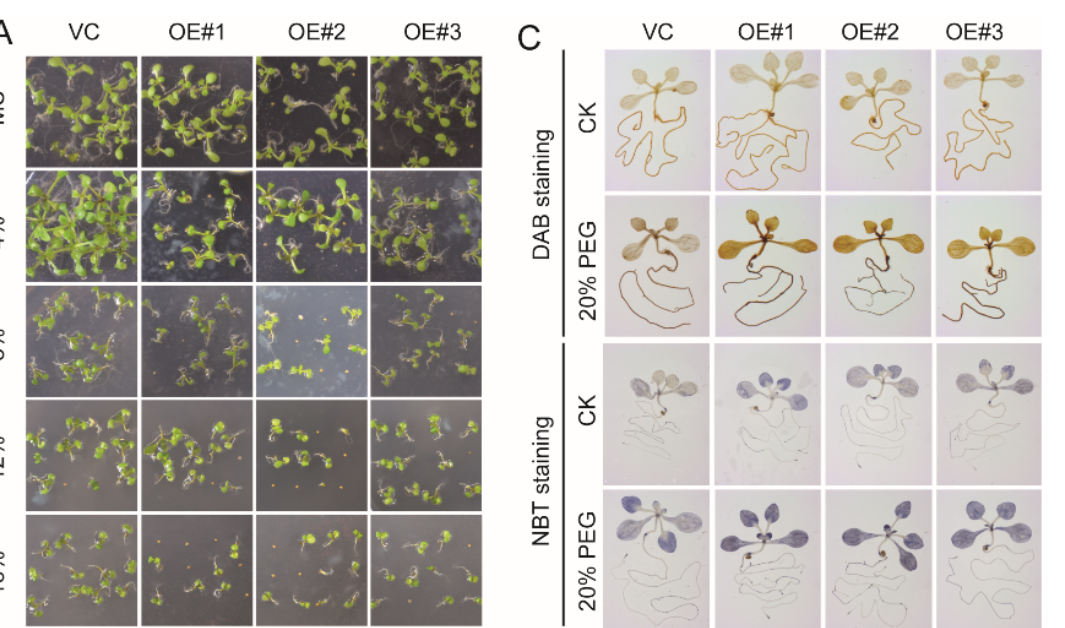
Figure 5. Response of RcTINY2 -OE Arabidopsis plants to drought stress. ( A ) Differential seed ger- mination response between RcTINY2 -OE and VC plants on PEG-treated (0, 4%, 8%, 12% and 16%) MS agar plates. All photographs were taken ten days after germination; ( B ) Green cotyledon rates of VC and RcTINY2 -OEs in response to PEG treatment. All data are the mean ± SD from five inde- pendently conducted experiments ( n = 16–20); ( C ) Ten-day-old VC and RcTINY2 -OE seedlings were stained with DAB (1 mg/mL) and NBT (1 mg/mL) for 12 h after PEG treatment for 30 min; ( D ) Ac- cumulation of H ₂ O ₂ in VC and RcTINY2 -OE plants after 30 min of PEG treatment. All data are the mean ± SD for three biological replicates. LSD tests were used to determine statistically significant differences ( p < 0.05) which are indicated by different letters. 3.6. Silencing of RcTINY2 Increases Salt and Drought Sensitivity in Rose Plants The VIGS system was used to examine the effect of RcTINY2 on both salinity and drought stress regulation in rose leaves. Under both salt- and water-stressed conditions, the expression of RcTINY2 was ~21% and ~37%, respectively, lower in TRV- RcTINY2 leaves than in TRV controls (Figure 6B,D). After either 6 or 12 h of dehydration, RcTINY2 - silenced leaves exhibited severe shrinkage compared to the TRV controls (Figure 6A). Treatment with 300 mM NaCl resulted in more injury to TRV- RcTINY2 leaves than to the TRV controls (Figure 6C). In addition, the fresh weight of TRV- RcTINY2 leaves was lower compared to the TRV controls after both dehydration and rehydration (Figure 6E). TRV- RcTINY2 leaves showed more electrolytic leakage and a lower chlorophyll content